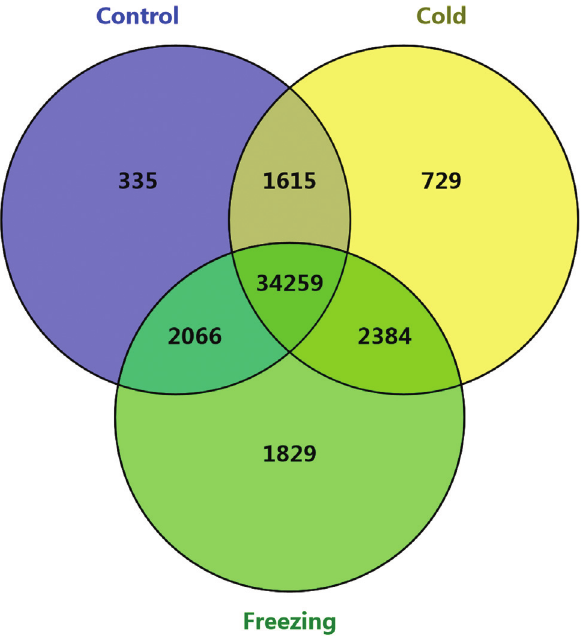
Figure 3 - Diagrammatic distribution of alfalfa expressed transcripts in different conditions.